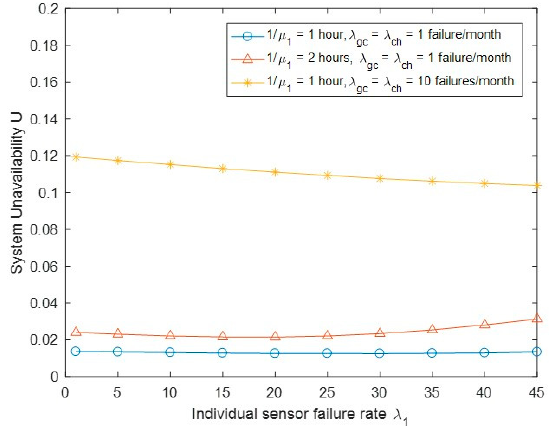
Figure 10. System unavailability U vs. biosensor failure rate λ 1.